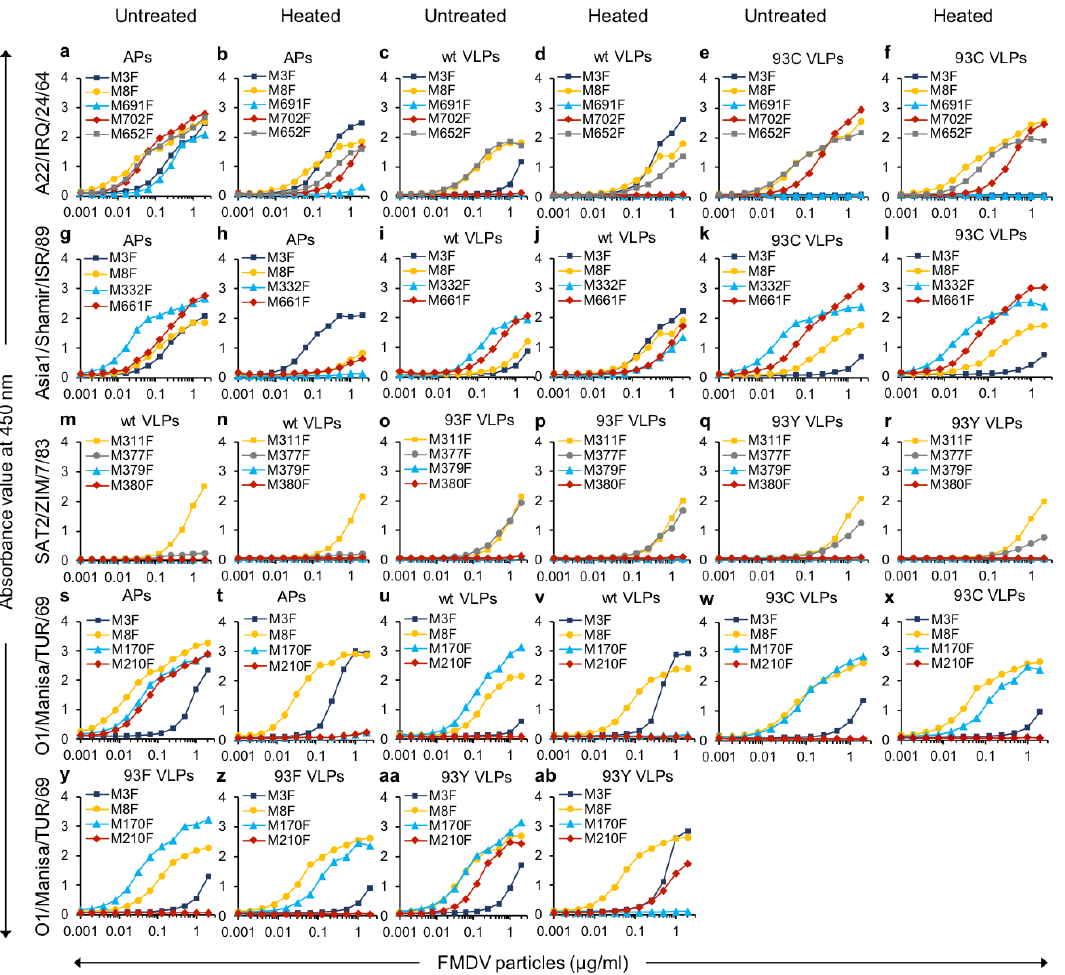
Figure 6. VHH binding to wild-type and stabilized mutant VLPs of various serotypes. The authentic particles (APs) or the different types of VLPs were either untreated or heated at 56 °C for 1 h as indicated on top of each column of panels. The strain used is indicated on the left of each row of panels. Different particles were two-fold titrated in DAS-ELISAs with a 2 µg/mL starting concentration. The control VHHs M8F and M311F, which bound all types of particles, are shown by a yellow curve in each panel. The 12S specific control VHH M3F is shown by a dark blue curve.